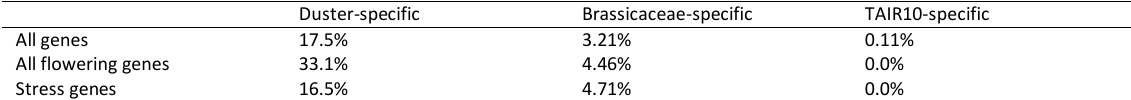
Table 3: Method-specific TEs overlap with the 500 bp immediately upstream from